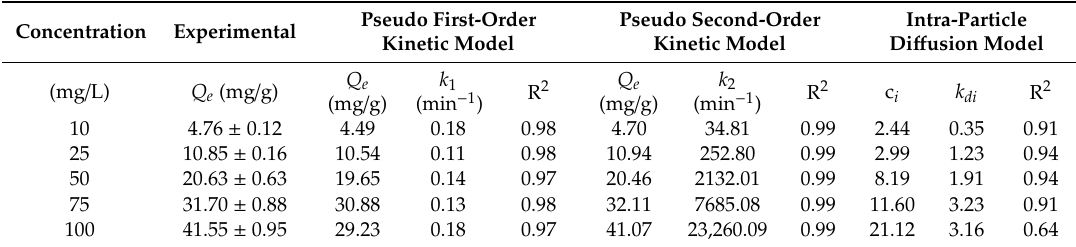
Table 2. Experimental data and model parameters for the adsorption of MB from pseudo first-order kinetic, pseudo second-order kinetic, and intraparticle di ff usion models at di ff erent dye concentrations. Concentration